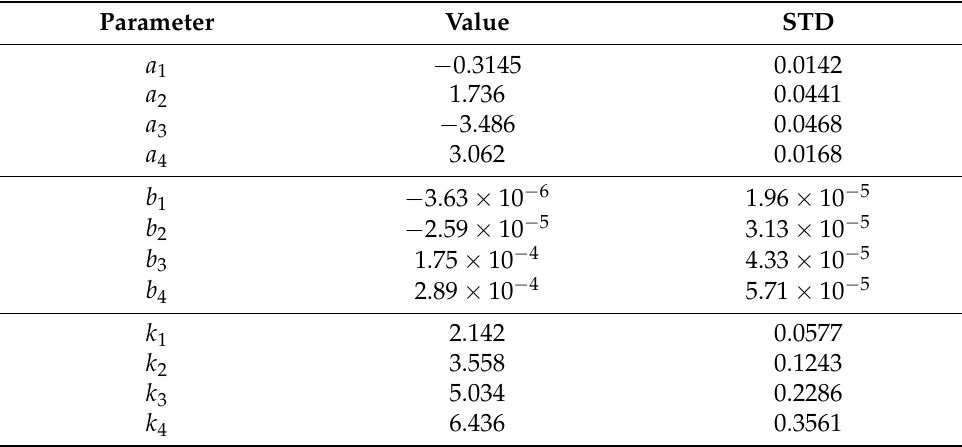
Table 1. Examples of unreliable model parameters and their STD